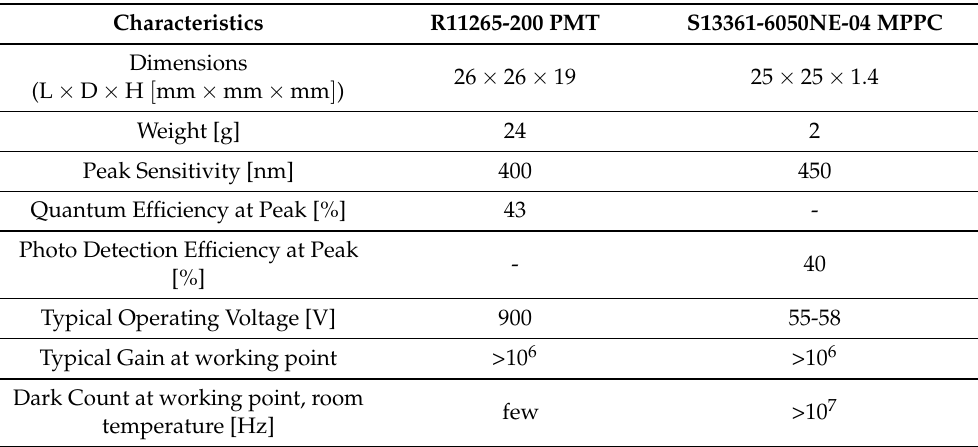
Table 3. Characteristics of the two devices (PMT and MPPC) considered in the